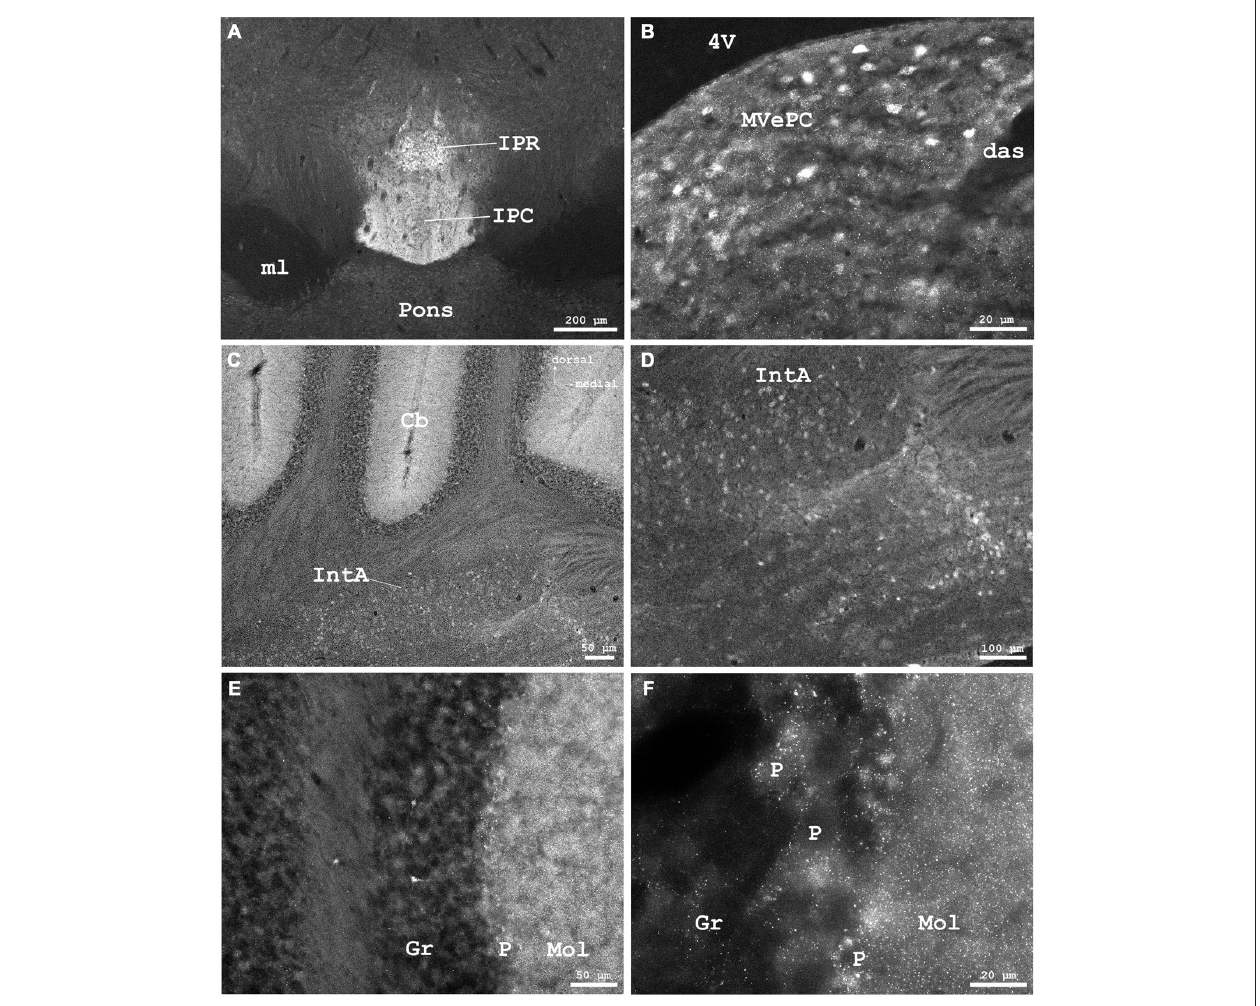
FIGURE 8 | (A) Cygb-immunofluorescence in a frontal section of the mouse brain at the level of approximately interaural 0, corresponding to Figure 62 of the mouse brain atlas showing labeled neurons in the rostral part of the interpeduncular nucleus (IPR) and labeled terminals in its caudal part (IPC), (B–F) were taken from a frontal section of the mouse brain at the level of approximately interaural − 2.4, corresponding to Figure 83 of the mouse brain atlas. (B) IR neurons and terminals in the medial vestibular nucleus, parvocellular part (MVePC). (C) Low power photomicrograph demonstrating cortical (upper part) and medullary regions (lower part) of the cerebellum (Cb). (D) Higher magnification of IR neurons in the anterior cerebellar nucleus interpositus (IntA). (E) Higher magnification from cerebellar cortex demonstrating IR neurons in the granular layer (Gr). IR puncta are present throughout the molecular (Mol) and Purkinje cell (P) layers. (F) Higher magnification demonstrating dense IR puncta surrounding unlabeled Purkinje cell somata (P) of the ganglionar cell layer. Abbreviations: 4V, fourth ventricle; das, dorsal acoustic stria; ml, medial